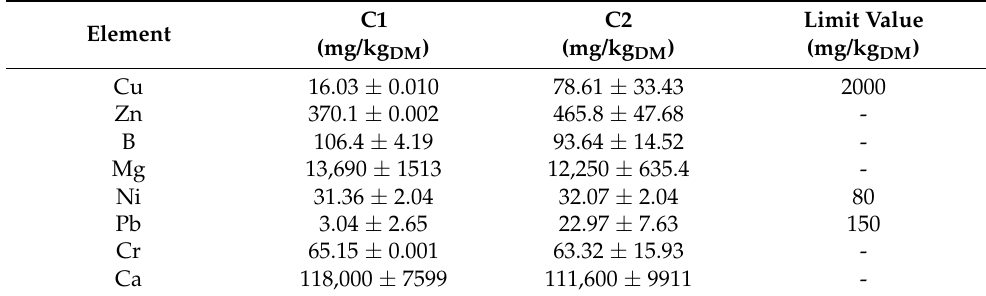
Table 1. Concentrations ± standard deviations of different minor and trace elements in the carbonated wood ash in mg/kg dry matter (DM): C1 (concentration prior to carbonation) and C2 (concentration after carbonation). Limit value according to the German Fertilizer Ordinance.